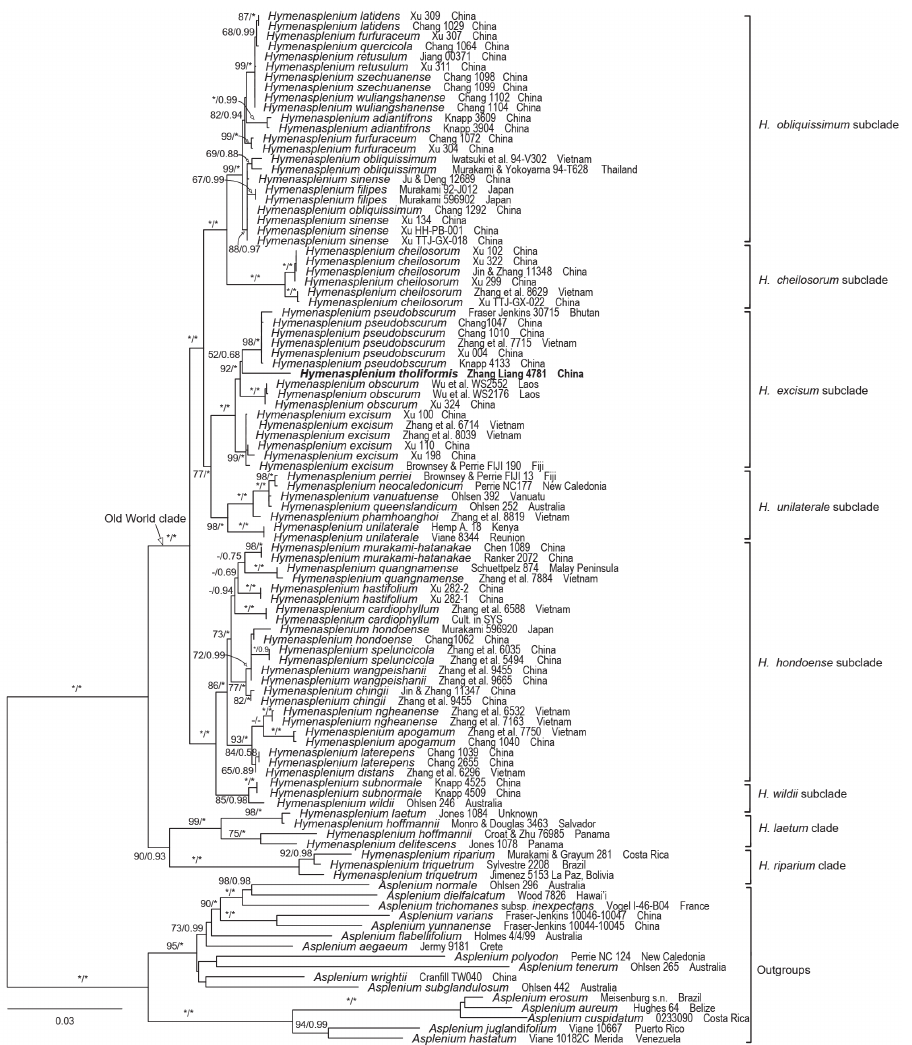
Figure 2. Maximum likelihood phylogeny of Hymenasplenium based on five plastid markers ( atpB , psbA , rbcL , rps4 & rps4-trnS , and trnL & trnL-F ). The numbers associated with branches are maximum likeli- hood bootstrap support (MLBS) and Bayesian posterior probability (BIPP). The asterisk indicates MLBS = 100, BIPP = 1.00. The subclades are indicated following Xu et al.